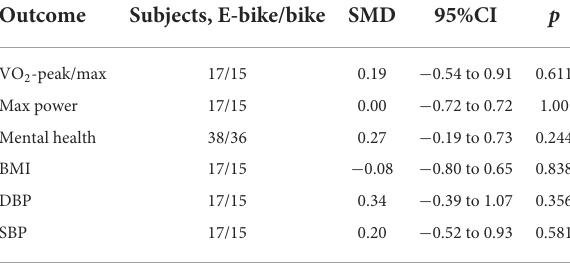
TABLE 3 The effect of E-cycling compared to conventional